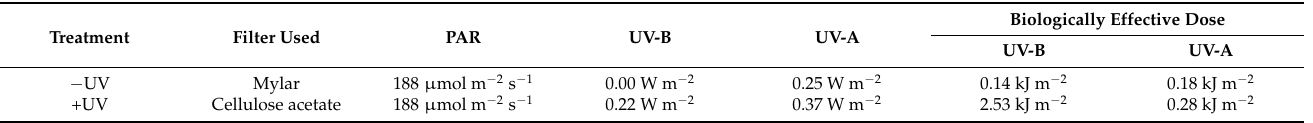
Table 2. Light conditions used in experiments. The biological effective daily dose was calculated using the action spectra formulae Gen-T